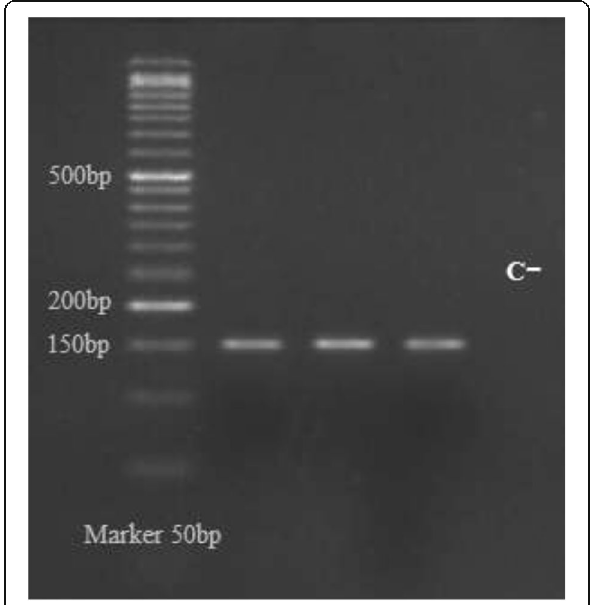
Fig. 2 Nested PCR products gel: The gel photograph represents the amplified fragments of promoter region carrying G238A in TNF- α gene by semi nested PCR. Lane 1: 50 bp ladder size marker; lanes 2, 3, and 4: 151-bp PCR product (semi-nested PCR); Lane 5: no template control